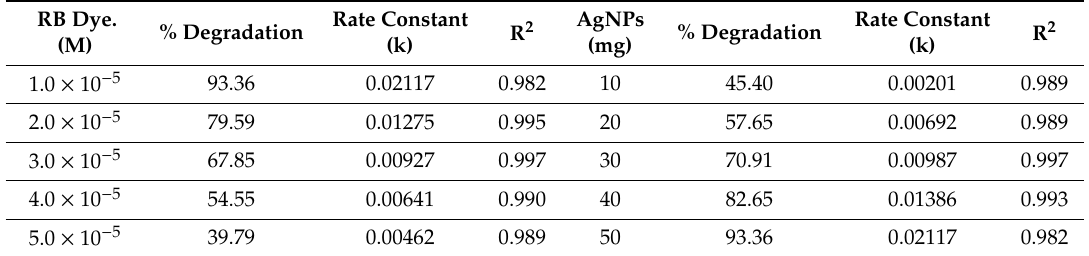
Table 2. E ff ect of RB and AgNPs dosages on the degradation e ffi ciency (%) and rate constant. RB